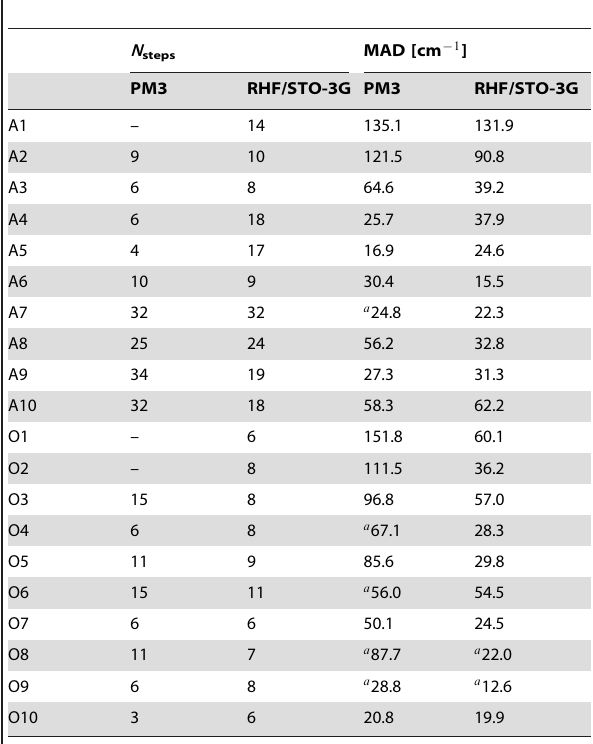
Table 4. Optimization steps and frequencies for solvated molecules.